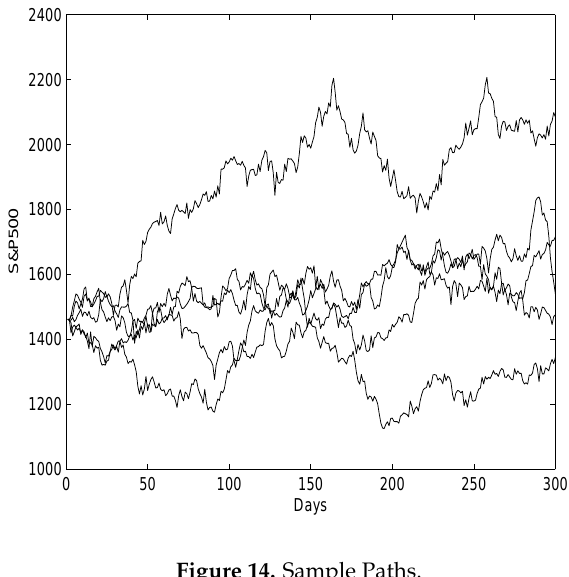
Figure 14. Sample